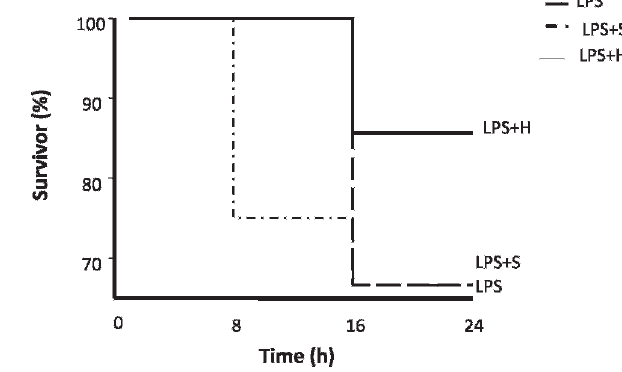
Figure 5 - Survival curve - The effect of treatment with SH or SS on the mortality of the endotoxemic rat challenged with intraperitoneal LPS (10 mg/kg) 15 min before the treatment. LPS + H group treated with SH; LPS + S treated with SS; LPS without treatment. n=10 mice per